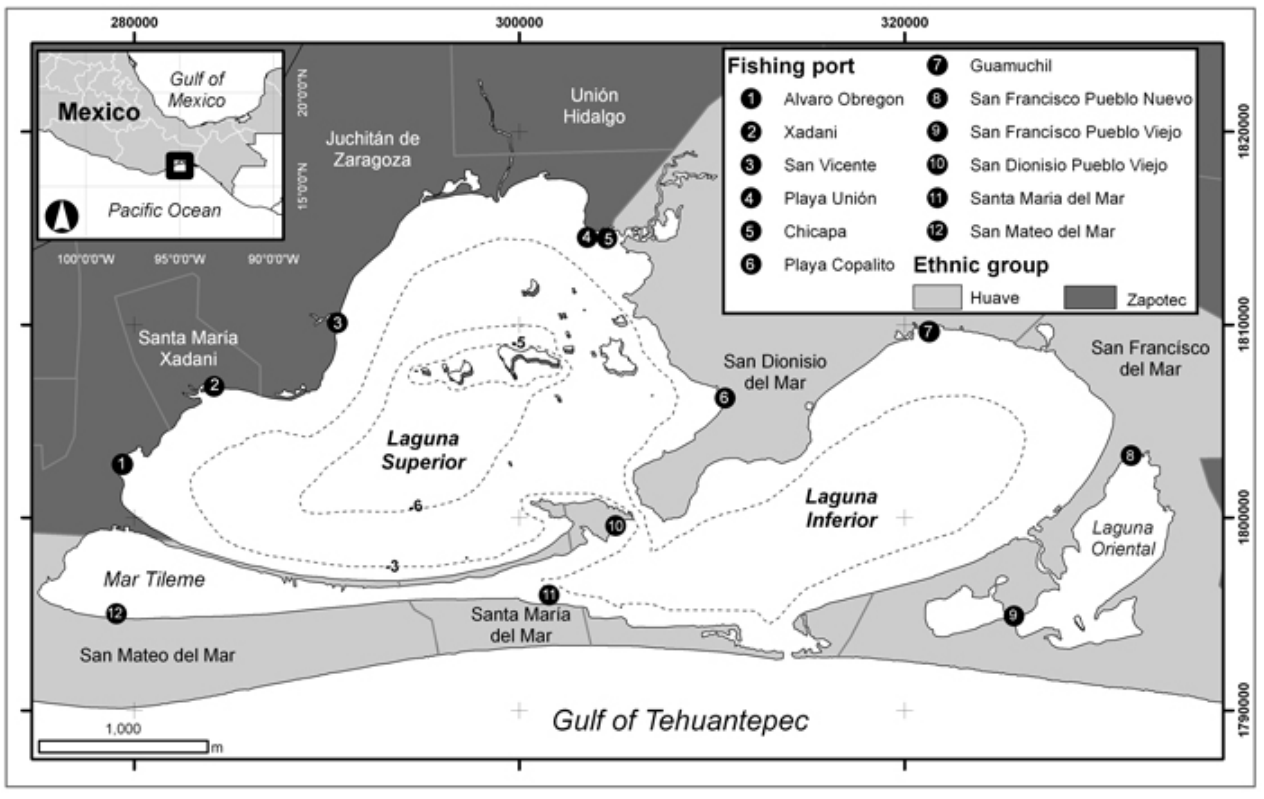
Fig. 1 . The ethnic influence and fishing ports around the Huave Lagoon System,